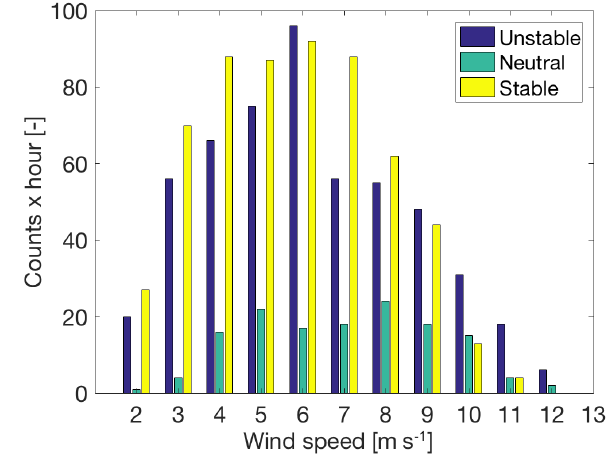
Figure 6. Stratification of the observations during the months of May and June 2015. The wind speed is estimated from the rotor- equivalent wind speed.